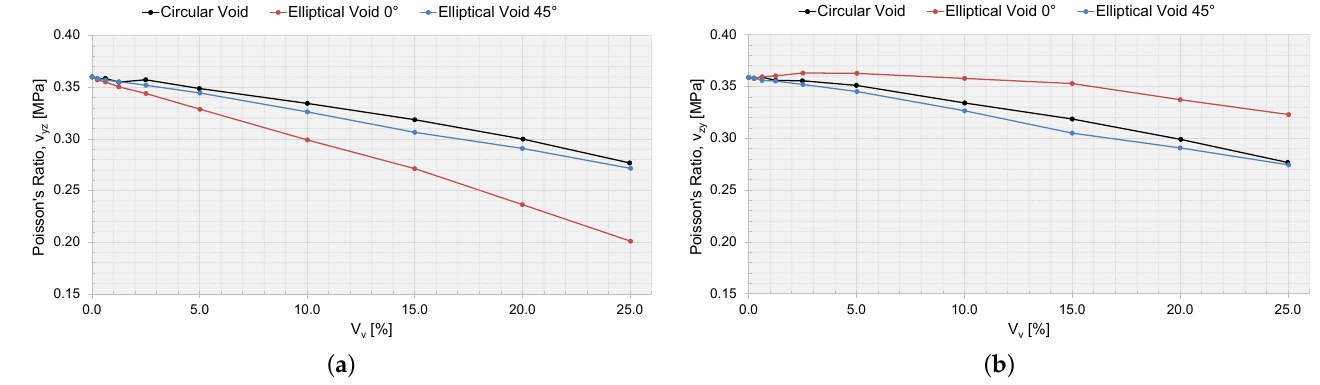
Figure 18. The effective macromechanical properties: ( a ) ν yz and ( b ) ν zy , as a function of void area, V v , for a 200 µ m RVE.